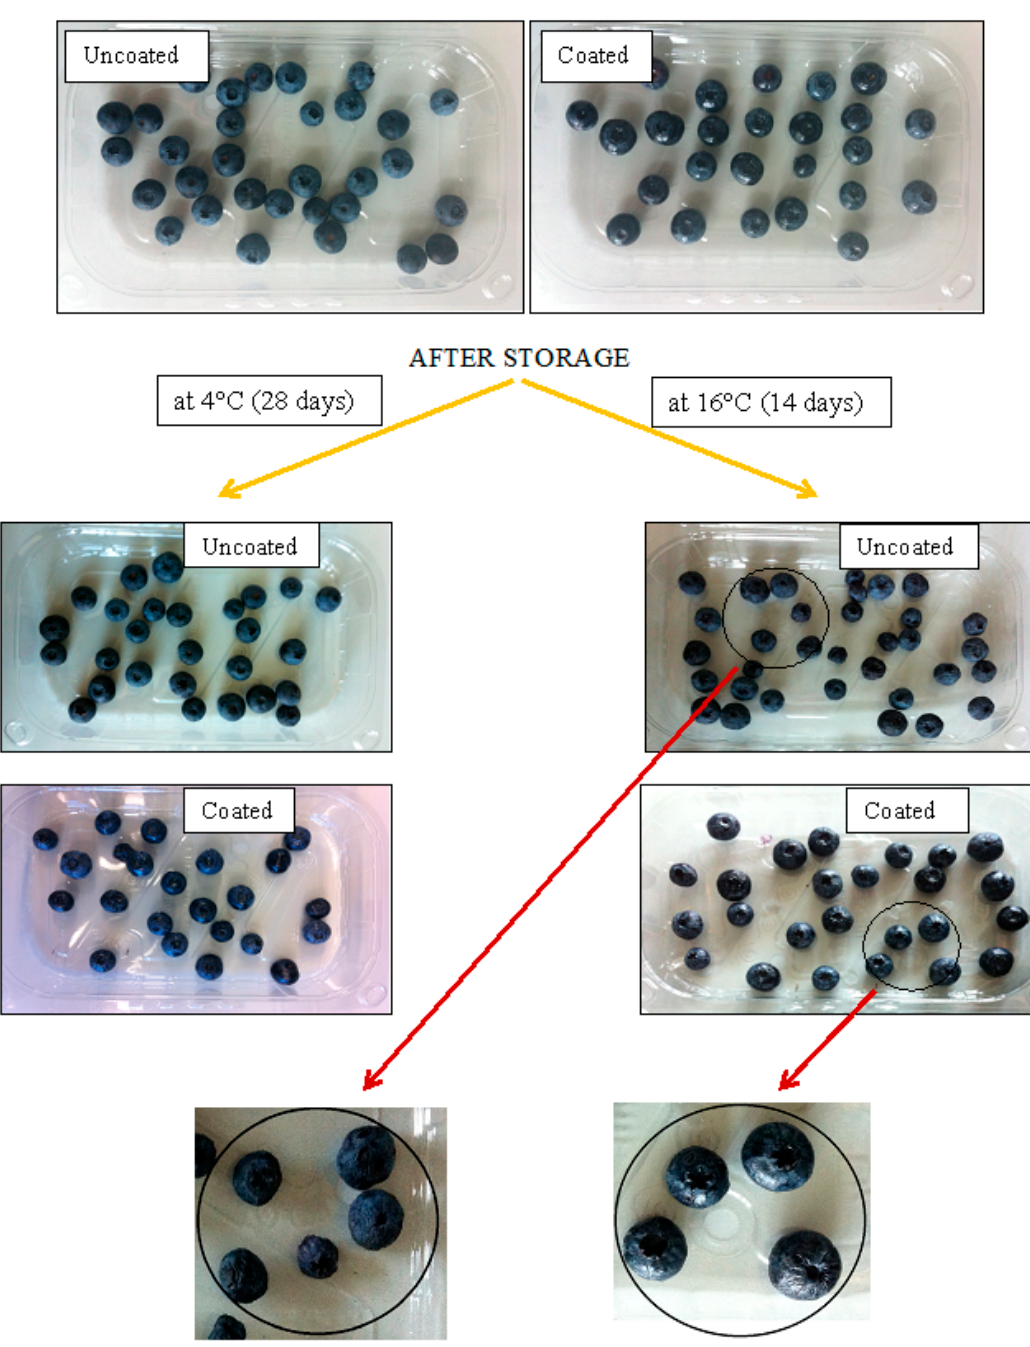
Figure 1. General appearance of blueberry samples before and after storage.